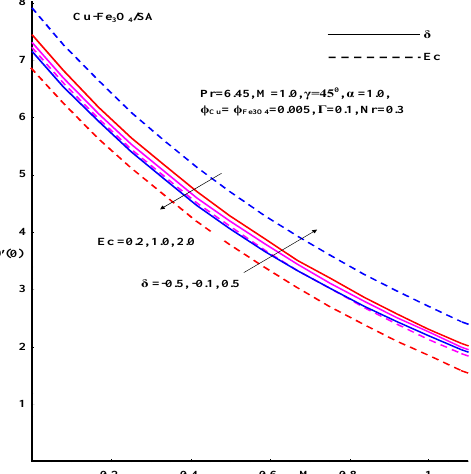
Figure 12. Effect of Eckert number and heat source/sink parameters on Nussult